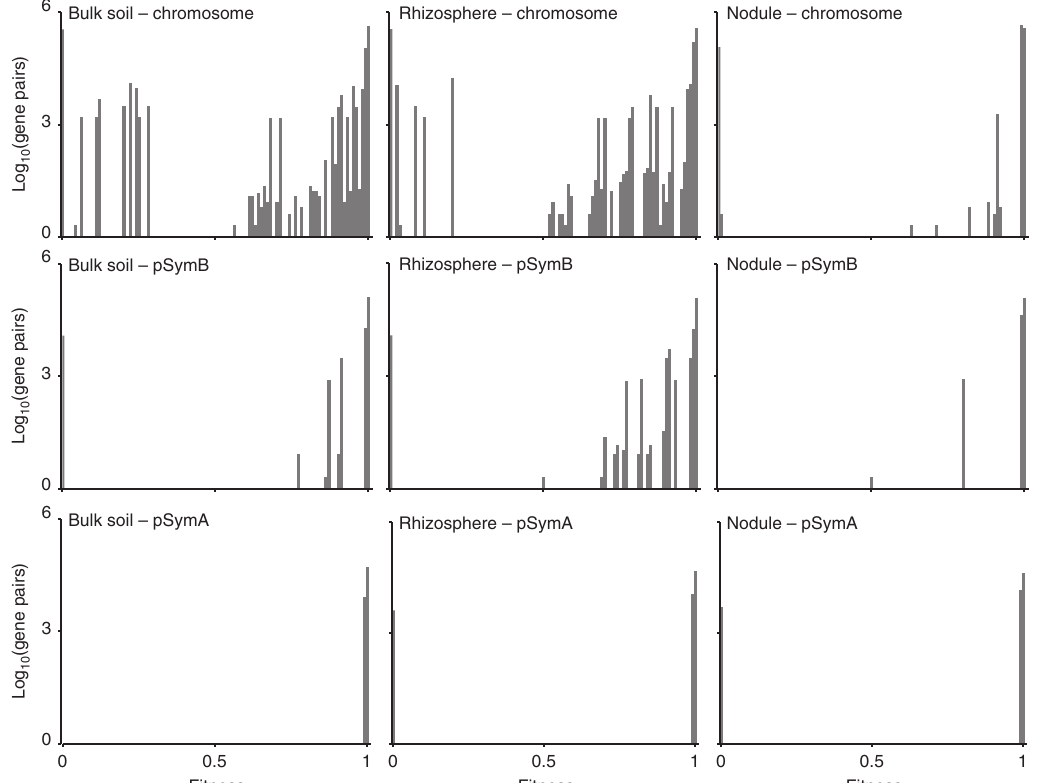
Figure 3 | Fitness costs associated with double gene deletions in the three tested ecological niches. All possible pairs of genes present on the same replicon were individually removed from the model, the ability of the resulting mutant to produce flux through the objective function was examined with FBA, and the fitness (solution value of the mutant/solution value of the wild type) of each mutant was calculated. The histograms summarize the calculated fitness values for each mutant in each of the three environments separately for each replicon. The fitness is displayed on the x axis, with the number of mutants displaying that fitness level on the y axis. The metabolic relevance of a replicon in a particular environment is represented by the number of mutants showing phenotypes between the two extremes (1 and 0); the greater the metabolic relevance, the greater the number of non-extreme